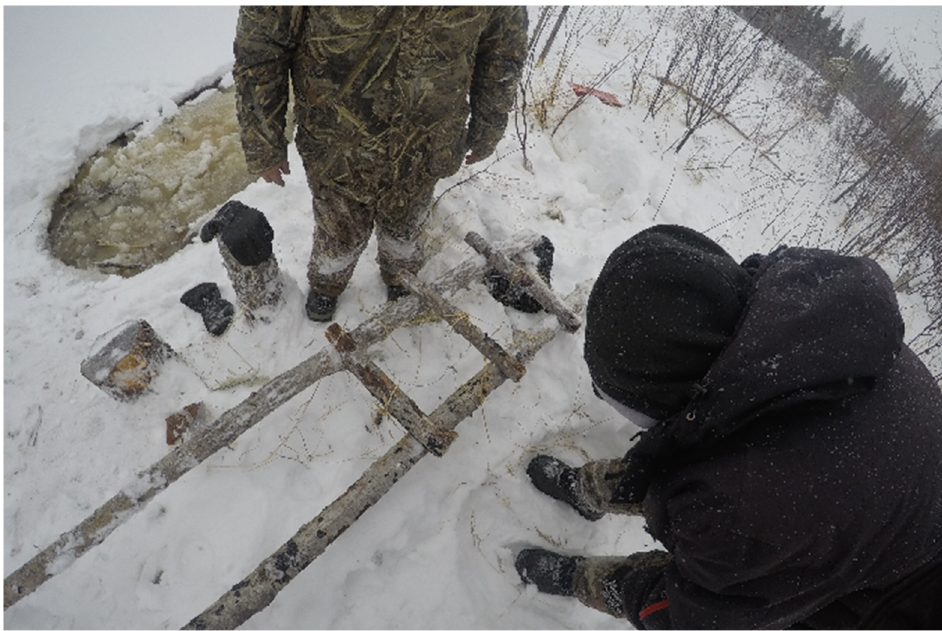
Figure 3. An on-the-land expert showing a youth participant how to set a snare for beaver trapping. Similarly, while looking at a photo, another participant stated, “I was raised in the bush eh” (Participant 1,